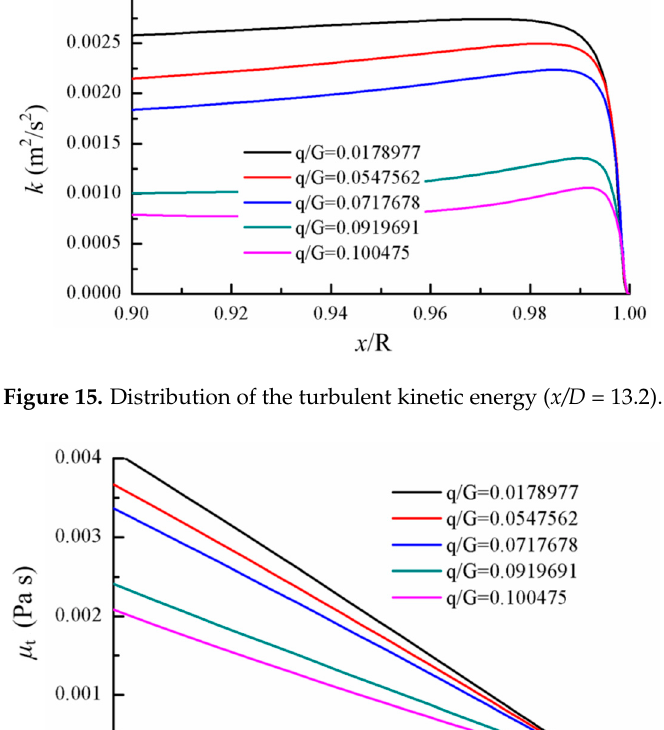
Figure 17. Distribution of the axial velocity ( x / D = 26).